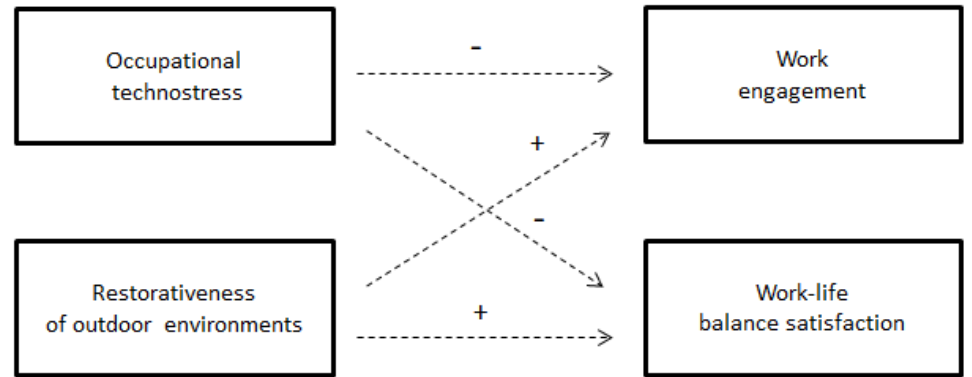
Figure 1. Research model: impact of occupational technostress and perceived restorativeness of natural outdoor environments in conditions of prolonged remote-working arrangements. The symbol “+” entail an hypothesized positive influence of the antecedent to the criteria variable. Conversely, the symbol “ − “ entails an hypothesized negative influence of the